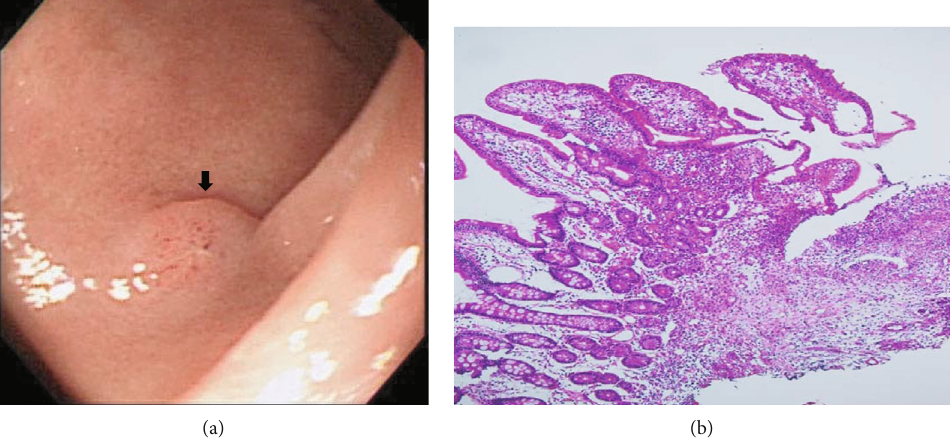
Figure 3: (a) Shallow ulcer over the infrapapillary area (arrow). (b) NK cell enteropathy composed of mononuclear cells in fi ltrating the duodenal mucosa. Further immunohistochemical staining con fi rmed the NK cell phenotype (CD3+/CD56+/TIA-1+) (H&E,